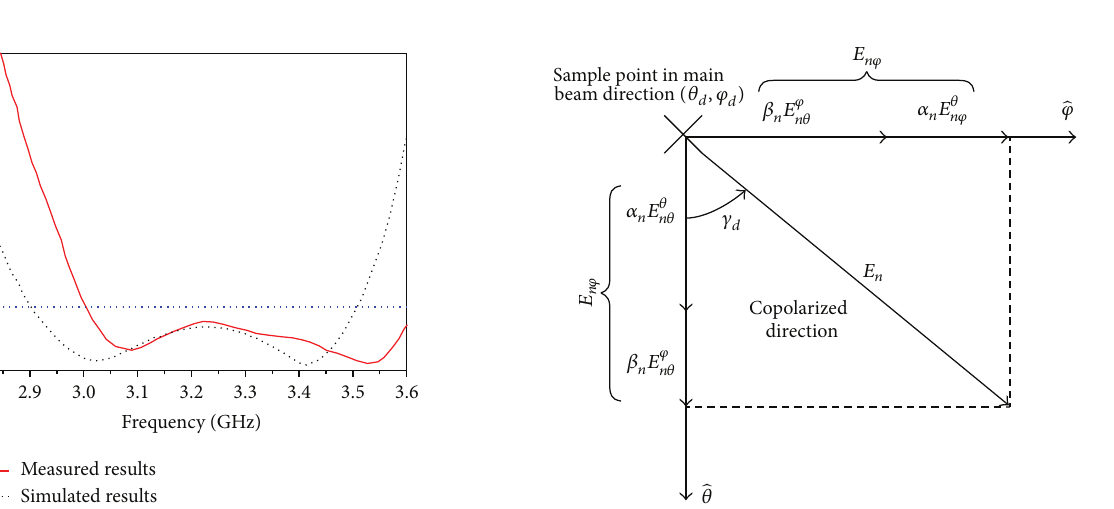
Figure 4: Simulated and measured VSWR for the antenna.